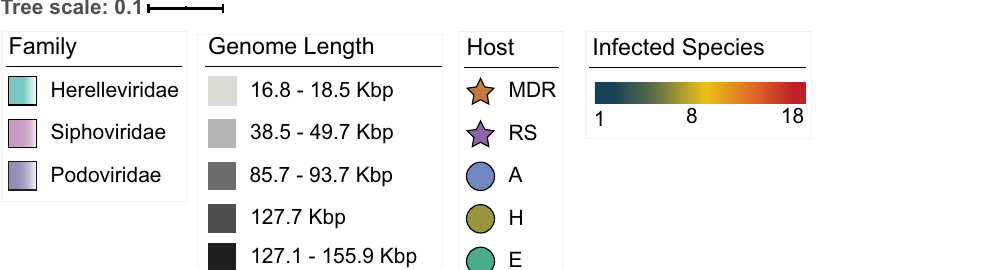
Fig. 6 Phylogenomic tree of staphylococcal phages. All published staphylococcal phages are displayed together with the here isolated and sequenced CoNS-infecting viruses. For each phage genus in brackets, a representative phage is indicated. The host range of the here characterized phages is represented as follows: the number of infected species is indicated using a continued color scale; isolation origin, and antimicrobial-resistant phenotype of infected hosts are represented using colored circles and stars, respectively. Phages infect A: hosts isolated from animals, H: hosts isolated from humans, E: hosts isolated from the environment. MDR: host is multidrug resistant. RS: phage infects hosts with antimicrobial-resistant and susceptible